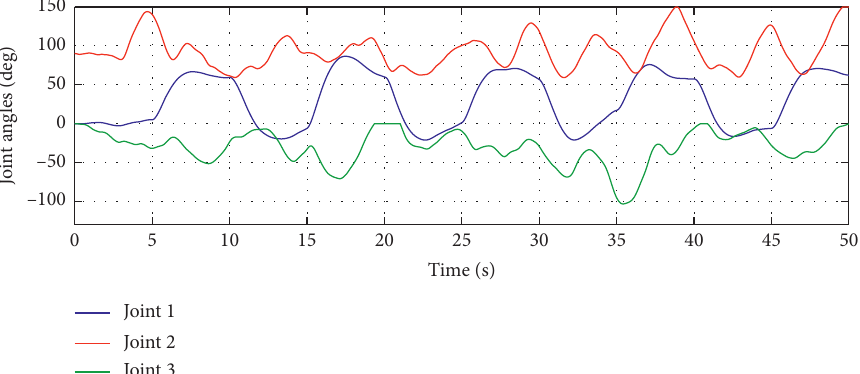
Figure 18: Random motions of the manipulator joints in Scenario 2.